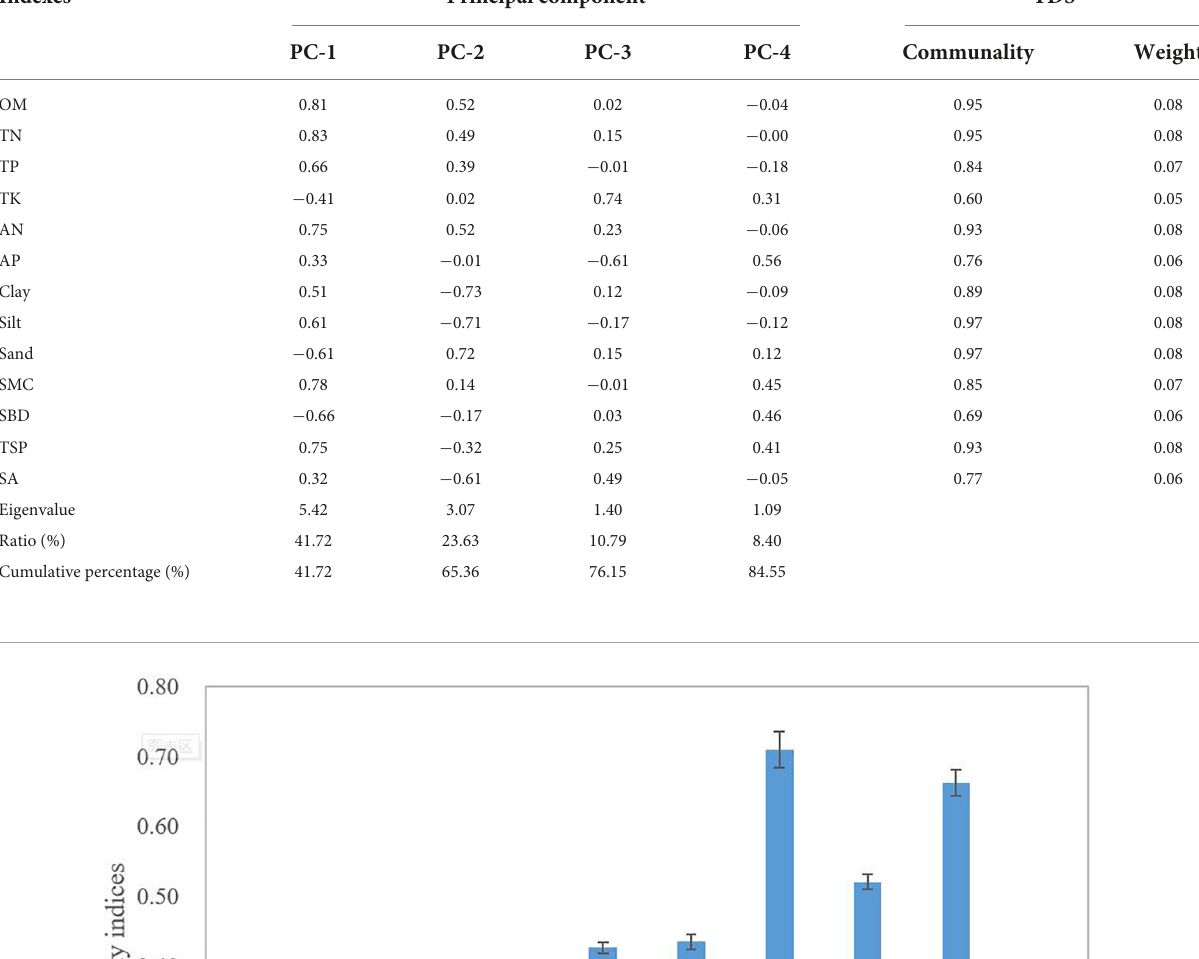
TABLE 3 Total data set (TDS) weights of soil in different afforestation years.